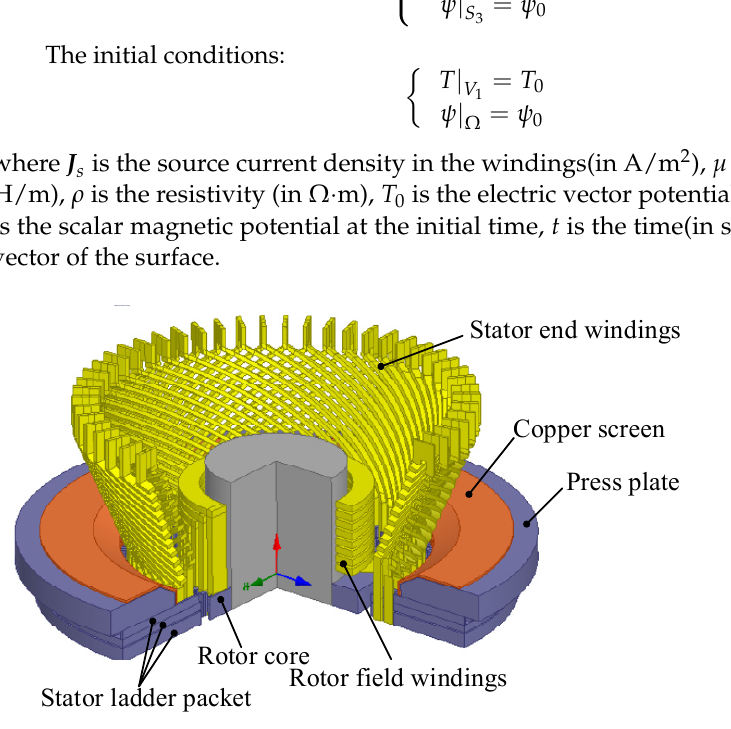
Figure 2. Physical model of the 330 million W water–hydrogen–hydrogen-cooling generator.